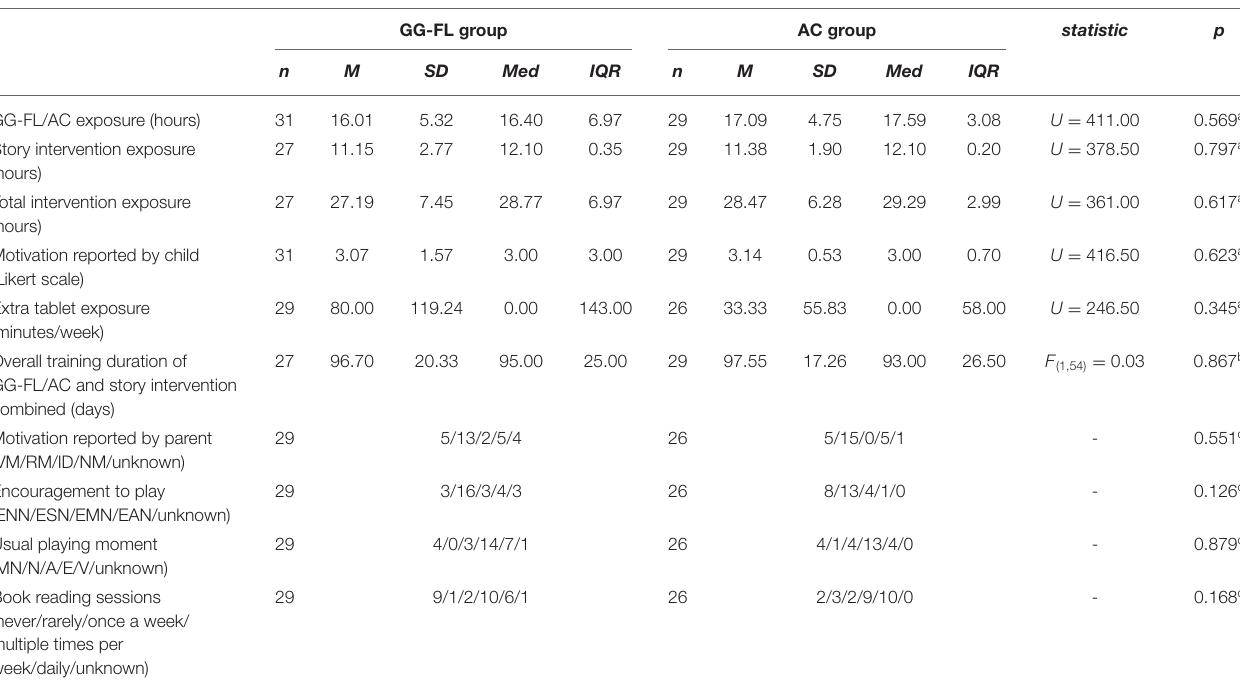
TABLE 3 | Group comparisons of intervention-related